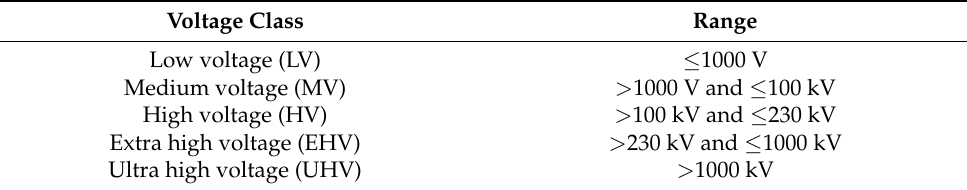
Figure 2. Microgrids classification. Table 2. Range voltage according ANSI